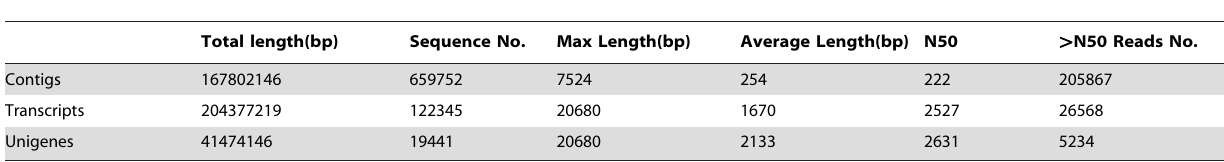
Table 1. Statistical summary of cDNA sequences of broccoli generated by the Illumina Miseq platform.